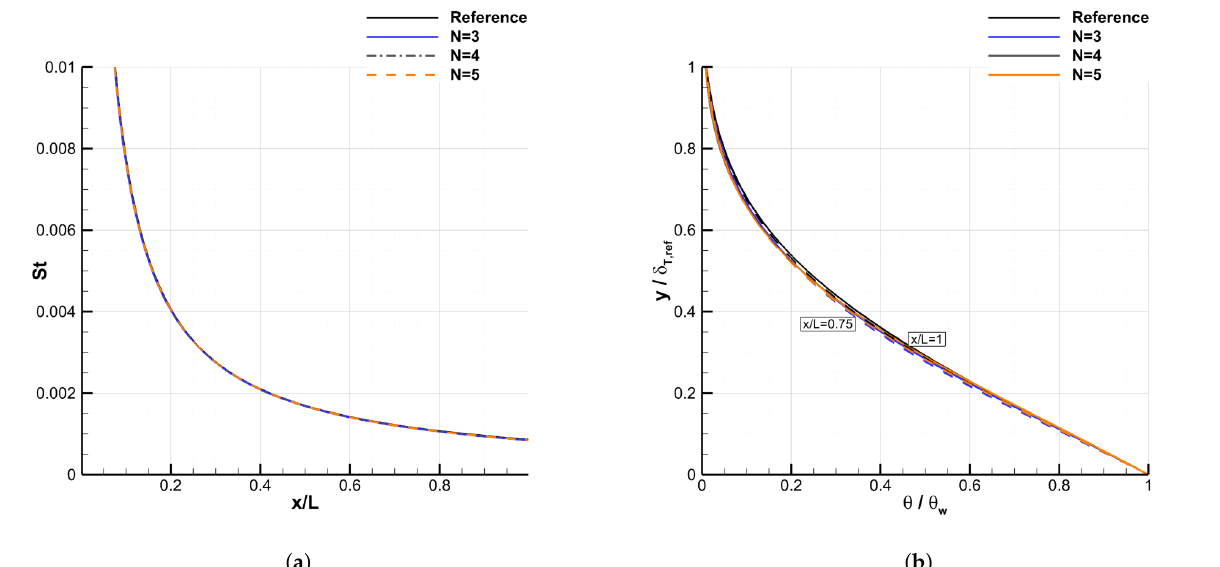
Figure 16. ( a ) Stanton number and ( b ) temperature profiles for several x / L locations. Test case 5, m = 1. N = 3 to N = 5, N x =